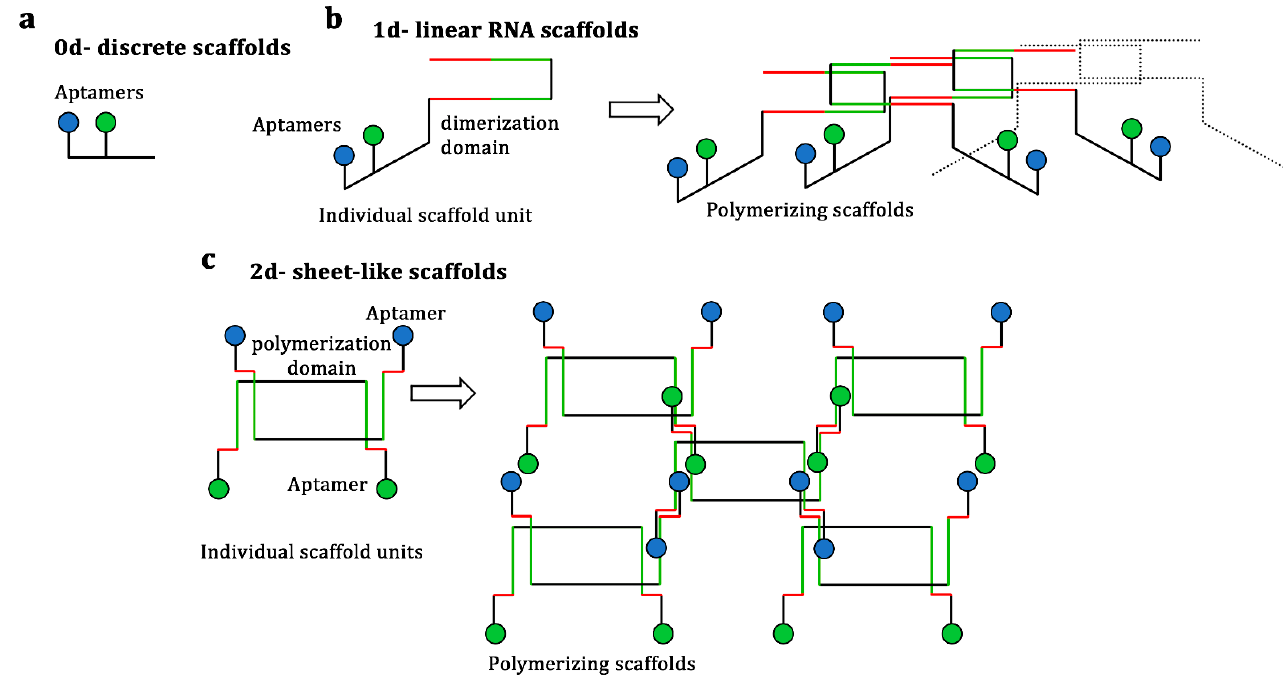
Figure 3. Multi-dimensionality of RNA scaffold systems. ( a ) In the case of a discrete RNA scaffold (zero dimension (0D)), a single RNA strand folds into a scaffold unit, generally presenting two aptamers for target pathway enzyme docking. ( b ) In the case of a one-dimensional (1D) RNA scaffold, each individual scaffold unit presents two aptamers and dimerization domains (red and green strands), which allow the individual units to form linear chains of aptamer sites through complementary base pairing. ( c ) In the case of a two-dimensional (2D) RNA scaffold, two different RNA strands, each presenting two aptamers, come together to form individual “tile” units. The polymerization domains (red strands) enable the polymerization of those units, resulting in the formation of 2D sheet-like structures through complementary base pairing [51].